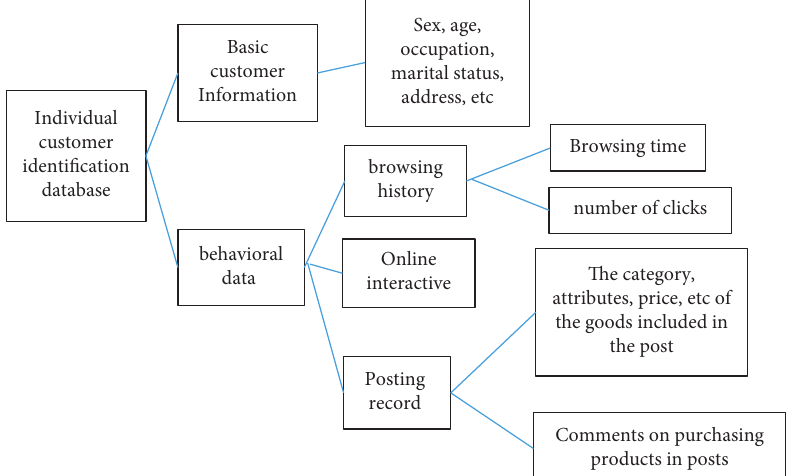
Figure 2: Individual customer identification database.